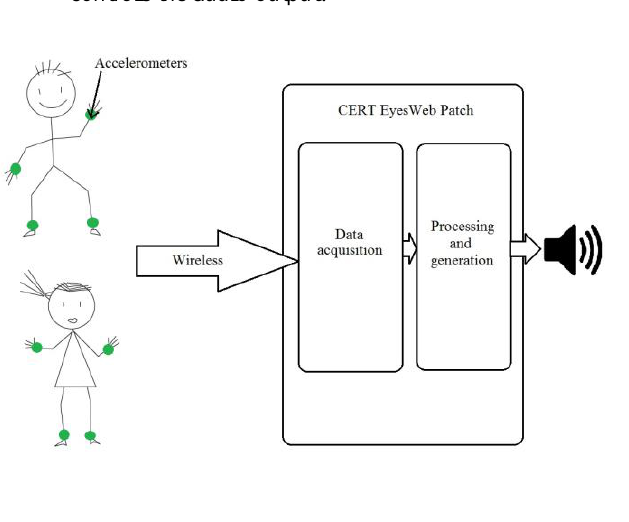
Figure 14. Architecture of CERT